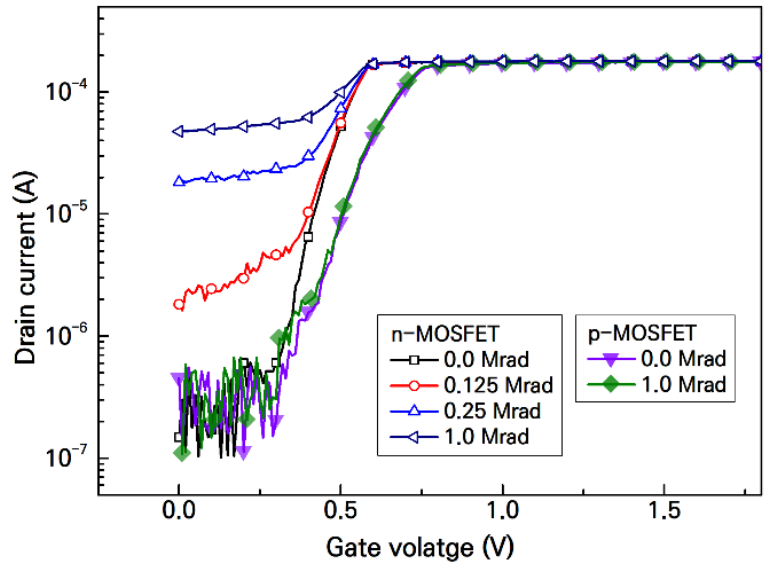
Figure 9. Leakage current measurement result according to the cumulative radiation of n-MOSFET and p-MOSFET (at 1 Mrad).